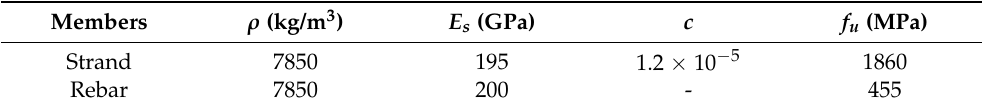
Table 3. Material properties of the steel